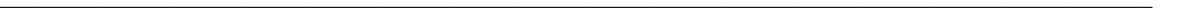
Fig. 6. Lower Ordovician, Tremadocian; A – J , Asaphellus inflatus Lu, 1962, Lower Ordovician, Tremadocian; A, NMW2012.45G.157.1, cranidium, sample MK-5/12; B, NMW2012.45G.152, cranidium, sample MK-5/11; C, NMW2012.45G.151, cranidium, sample MK-5/11; D, NMW2012.45G.318, cranidium, sample MK-5/12A; E, NMW2012.45G.158.1, internal mould of librigena, sample MK-5/12; F, NMW2012.45G.153.1, internal mould of librigena, sample MK-5/11; G, NMW2012.45G.162, librigena, sample MK-5/12A; H, NMW2012.45G.155, pygidium, sample MK-5/11; I, NMW2012.45G.160, pygidium, sample MK-5/12A; J, NMW2012.45G.157.2, internal mould of pygidium, sample MK-5/12. K , L , Asaphellus sp., Lower Ordovician, Tremadocian; K, NMW2012.45G.381, internal mould of pygidium and part of thorax, sample MK-5/14; L, NMW2012.45G.382, internal mould of hypostome, sample MK-5/14. M , Orometopus sp., Lower Ordovician, Tremadocian NMW2012.45G.384, internal mould of cranidium, sample MK-5/14. N , Chashania cf. chashanensis Lu & Sun in Zhou et al., 1977, NMW2012.45G.385, latex cast of cranidium, sample MK-5/10. O , P , Psilocephalina lubrica Hsü, 1948, Lower Ordovician, Tremadocian, sample MK-5/14; O, NMW2012.45G.386, cranidium; P, NMW2012.45G.387, pygidium. All scale bars are 2